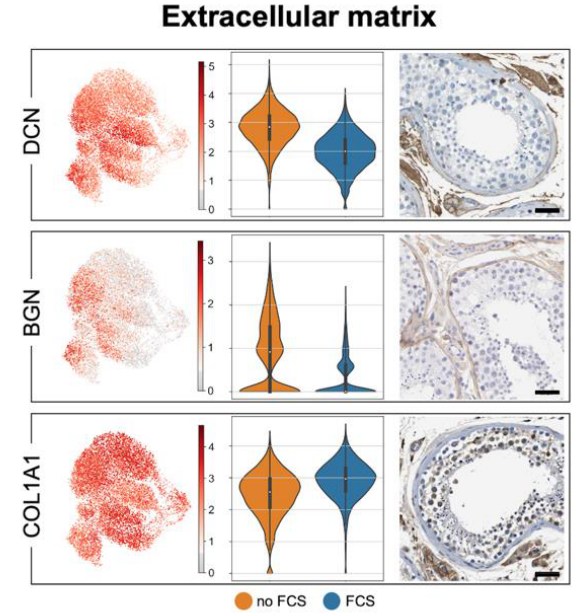
Figure 4. ECM components. UMAP plots of ECM components produced by HTPCs and typically